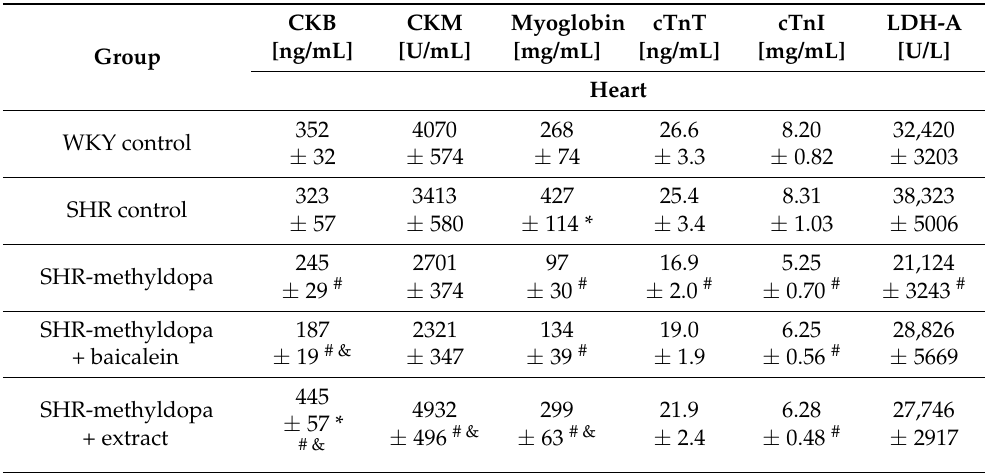
Table 2. Influence of methyldopa and its combination with baicalein or extract from Scutellaria baicalensis roots on levels of selected factors related to heart damage parameters (level of: creatine kinases (B, M), myoglobin, troponins (cTnC, cTnI), lactate dehydrogenase) in SHR pregnant